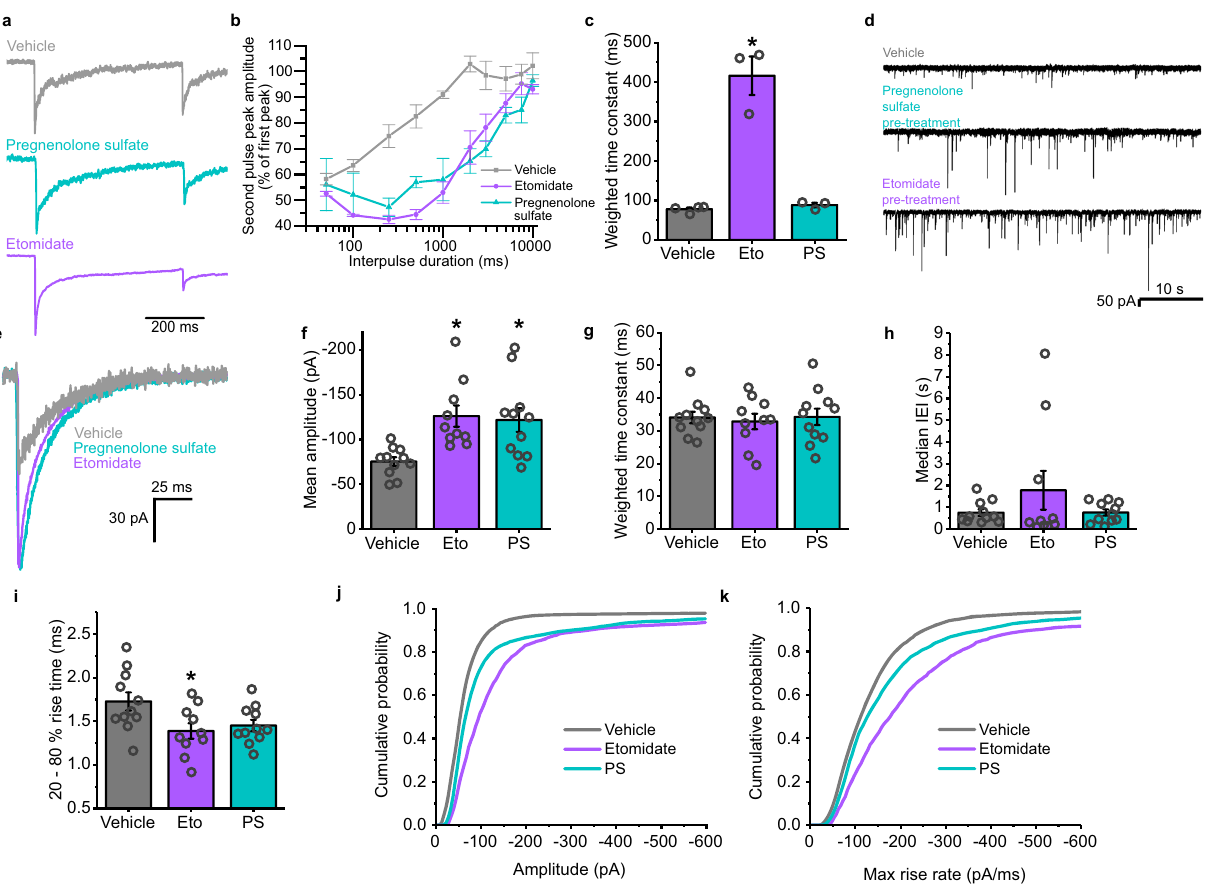
Fig. 10 Allosteric modulators of GABA A Rs that increase the occupancy of the desensitized state also induce iLTP. a Averaged GABA currents of GABA A Rs in outside-out patches pulled from transiently transfected HEK293 cells, to sequential pulses of 10 mM GABA in the presence of vehicle, 10 μ M pregnenolone sulfate (PS, light blue), or 5 μ M etomidate (purple). b Re-sensitization of the second GABA current with increasing interevent intervals in the presence of the indicated modulators; n = 4, 3, and 3, respectively, for each condition. c Weighted decay time constants for GABA current responses in control and exposed to the modulators (Eto = etomidate, PS = pregnenolone sulfate; one-way ANOVA: F (2,7) = 55.9, p = 0.00005; Tukey test (vehicle vs etomidate): p = 0.00007; Tukey test (etomidate vs pregnenolone sulfate): p = 0.0001). d Representative sIPSCs recorded from neurons pretreated with the indicated modulators (vehicle, 1 µ M pregnenolone sulfate or 5 µ M etomidate). e Average sIPSC waveforms for each modulator aligned on the current rising phases. f Mean sIPSC amplitudes (one-way ANOVA: F (2, 29) = 7.19, p = 0.0029; Tukey test (mock vs PS): p = 0.0099; Tukey test (mock vs etomidate): p = 0.0058) and g weighted decay time constants for sIPSCs recorded after treatment with the indicated modulators (one-way ANOVA: F (2,29) = 0.11, p = 0.89). h Median IEIs for the sIPSCs recorded from neurons after treatment under the indicated conditions (one-way ANOVA (IEI) F (2,29) = 4.25, p = 0.27). i 20 – 80% rise times of sIPSCs recorded after treatment (one-way ANOVA (rise times) F = 4.25, p = 0.024; Tukey test (Mock vs (2,29) Etomidate): p = 0.029; Tukey test (Mock vs PS): p = 0.078). j Cumulative probability distribution of the sIPSC amplitudes. k Maximum rate of rise slopes of all sIPSCs recorded; n = 3930 events from 11 cells, 8646 events from 10 cells and 4467 events from 11 cells, respectively. Source data are provided as a Source data fi le for Fig. analysis were also discarded if they displayed any secondary peaks during the decay glutamate receptor activity. Bath temperature was controlled either by working at a phase. Conversely, for the calculation of rise-rates, interevent intervals, and the controlled ambient temperature (21 °C, as measured with a thermometer and production of cumulative probability distributions, all detected events were thermocouple immersed in the bath solution), or by warming the bath solution included. Decay curves were fi tted to average sIPSC waveforms using a standard with an inline heater to 37 °C (con fi rmed by insertion of a thermocouple into two component exponential function in ClampFit. Weighted time constants were the bath). determined from For experiments involving drug pre-treatments, fi nal drug concentrations were added to the maintenance media (see above) of the cultured neurons, and the dishes were subsequently returned to the cell incubator for the duration of the treatment (20 min). The coverslips were then removed and placed into the recording chamber. Krebs solution was washed over the coverslip for 25min prior to recording to ensure washout of the drug. For recordings performed 24 h after Where a indicates the relative weighting of each exponential component and t GABA treatment, the treatment media was removed, and the cells were washed 5× indicates the time constant of each component. Rise-time slopes were calculated in HBSS, followed by one 20-min wash in fresh maintenance media before being using the maximum rate of rise function in ClampFit on data fi ltered at 2 kHZ (8- returned to conditioned media harvested from the cells prior to the treatment. pole Bessel). For presentation purposes only, current records were further fi ltered Spontaneous IPSCs were identi fi ed in 5 min recording epochs using Clamp fi t with a 1kHz 8-pole Bessel fi lter. (version 10.7, Molecular Devices) in conjunction with a template pattern search For peak-scaled non-stationary variance analysis, synaptic events were selected (generated from examples of sIPSC rise pro fi les and peak currents recorded from that displayed both clean rise and decay phases (without in fl ections, secondary control cultured hippocampal neurons at the same temperature). All recorded peaks, or noise artefacts). These events were imported into WinWCP v5.2.3 events were visually inspected. For the calculation of mean amplitudes, events were (Dempster, 2015), and the peak of the averaged sIPSCs was aligned to the peaks of discarded if they displayed in fl ections on the rising phase. Events used for kinetic individual sIPSCs selected for analysis. The decay phases of individual sIPSCs were